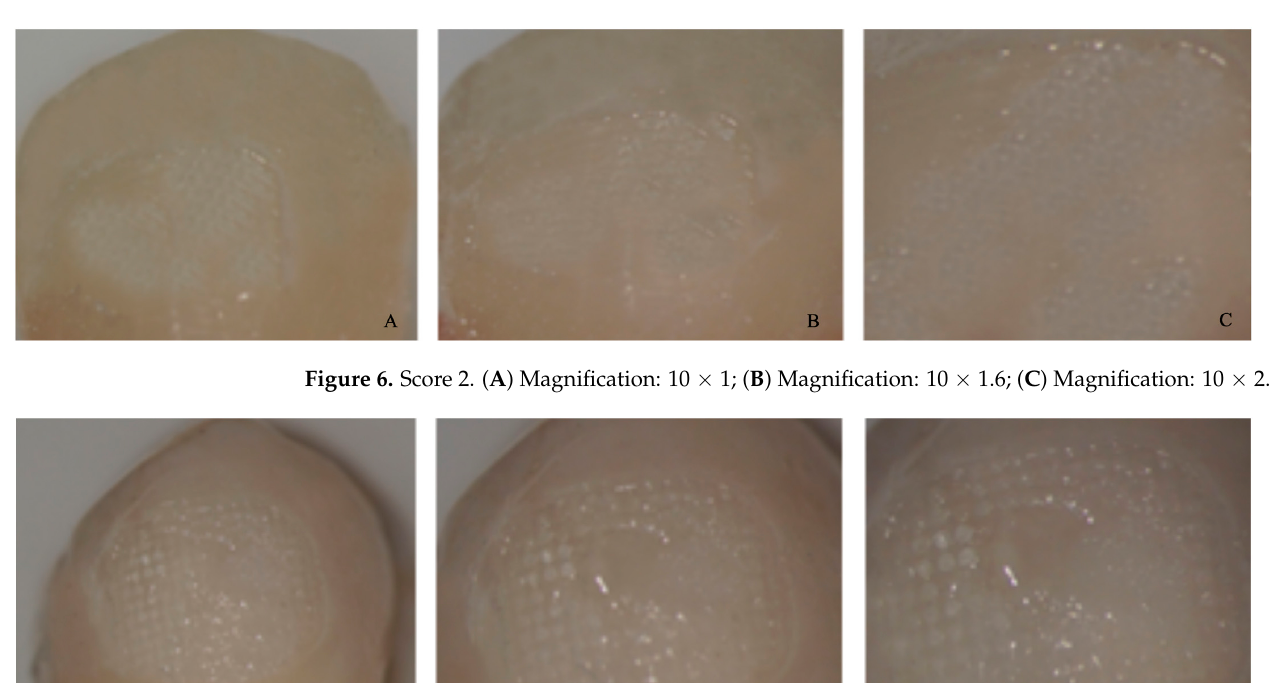
Figure 5. Score 1. ( A ) Magnification: 10 × 1; ( B ) Magnification: 10 × 1.6; ( C ) Magnification: 10 × 2.5.